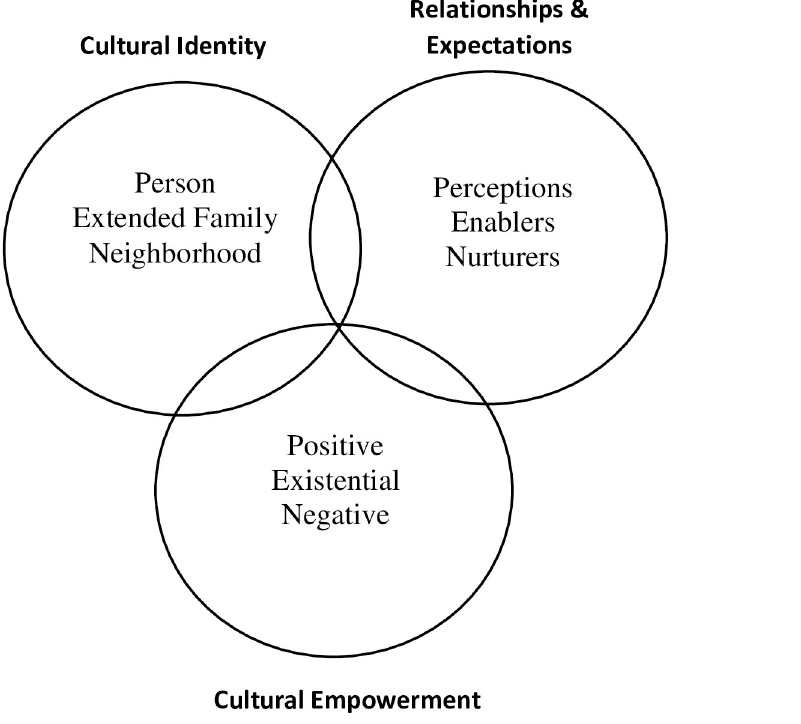
Fig 1. The PEN-3 cultural model [adapted from Iwelunmor et al. [31]].